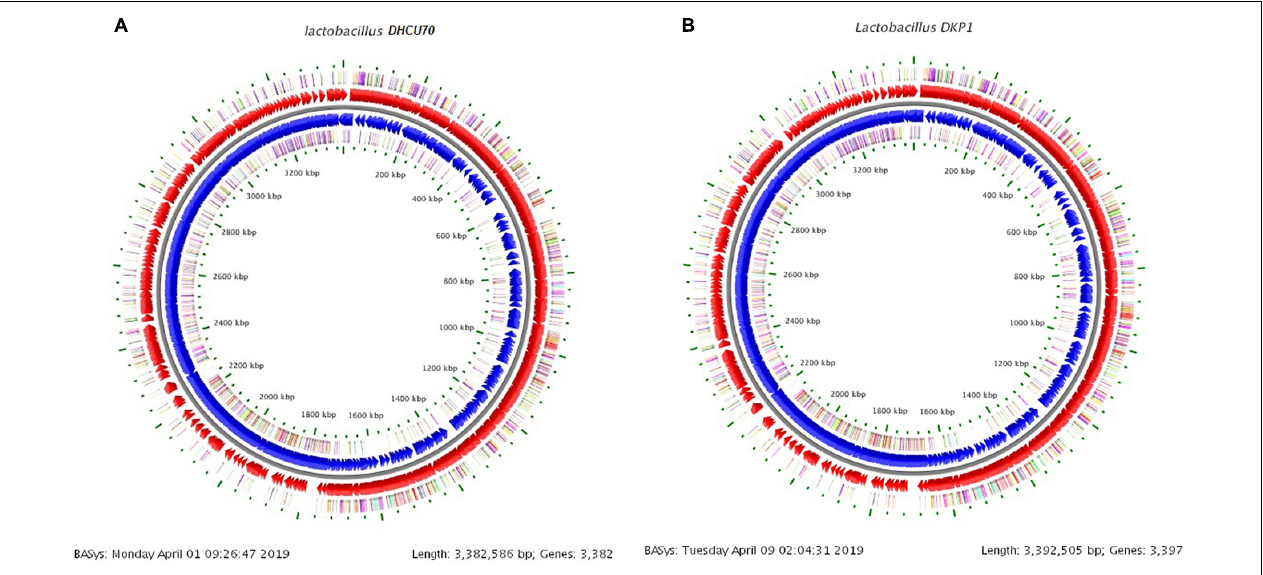
FIGURE 3 | (A) Circular genome map of Lactobacillus plantarum DHCU70; (B) Circular genome map of Lactobacillus plantarum